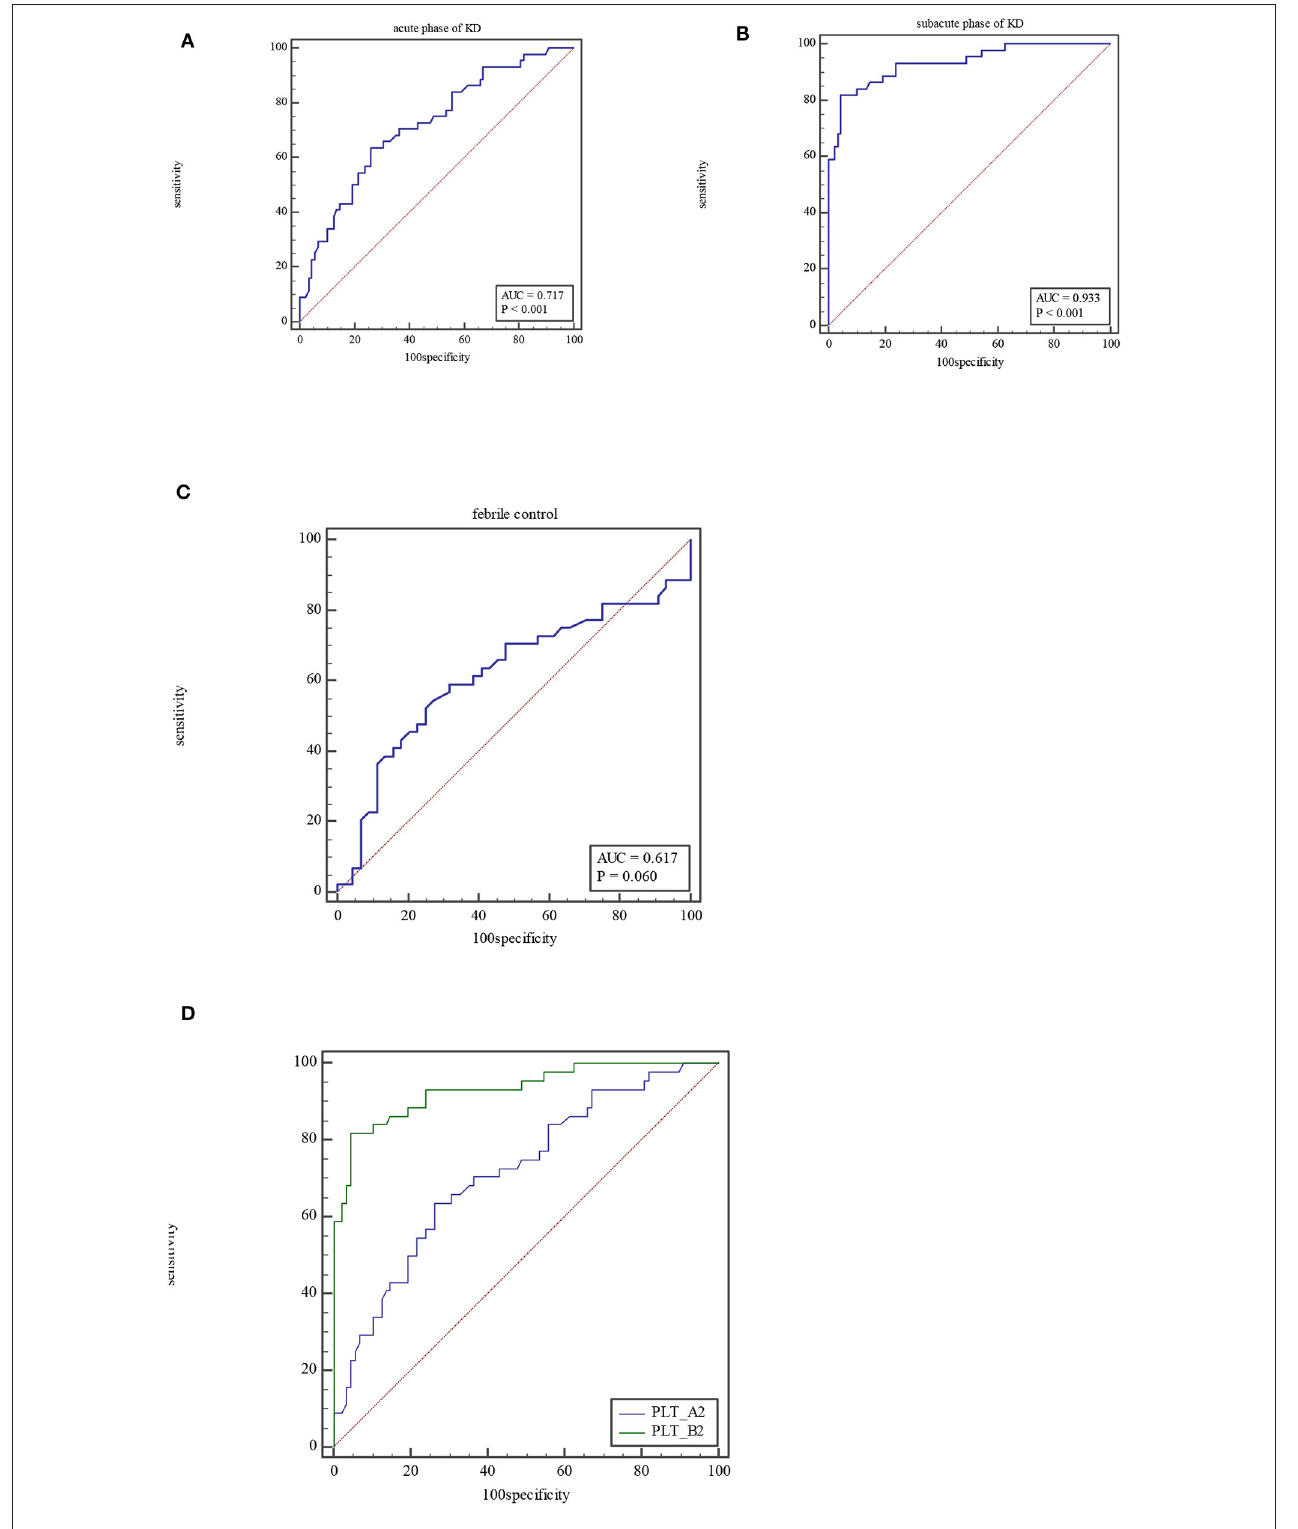
FIGURE 2 | ROC curve of PLT at acute phase of KD (A) , subacute phase of KD (B) , and febrile control corhort (C) . Comparison of ROC for PLT between at acute phase of KD and subacute phase (D) .